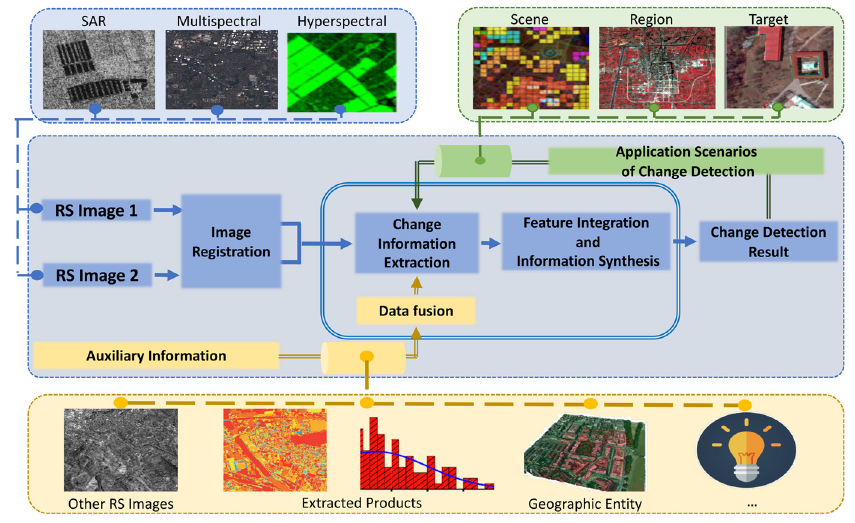
Figure 2. The general framework of urban change detection.